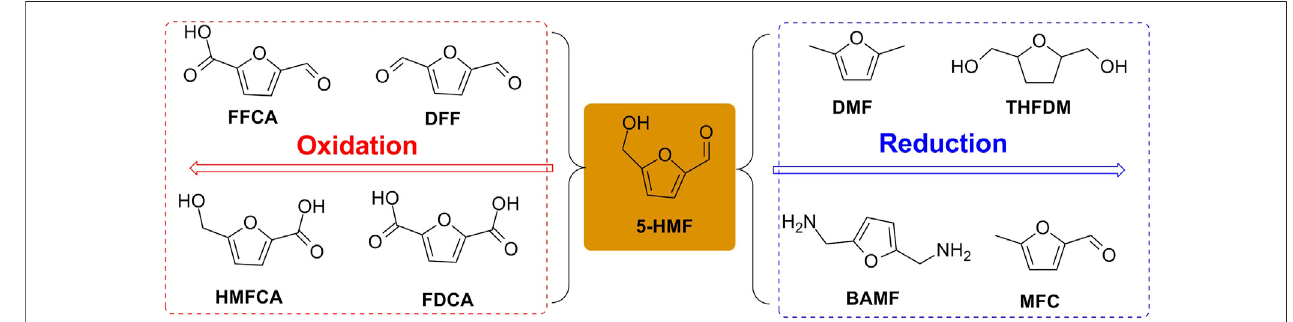
FIGURE 3 | Transformation of 5-HMF into its